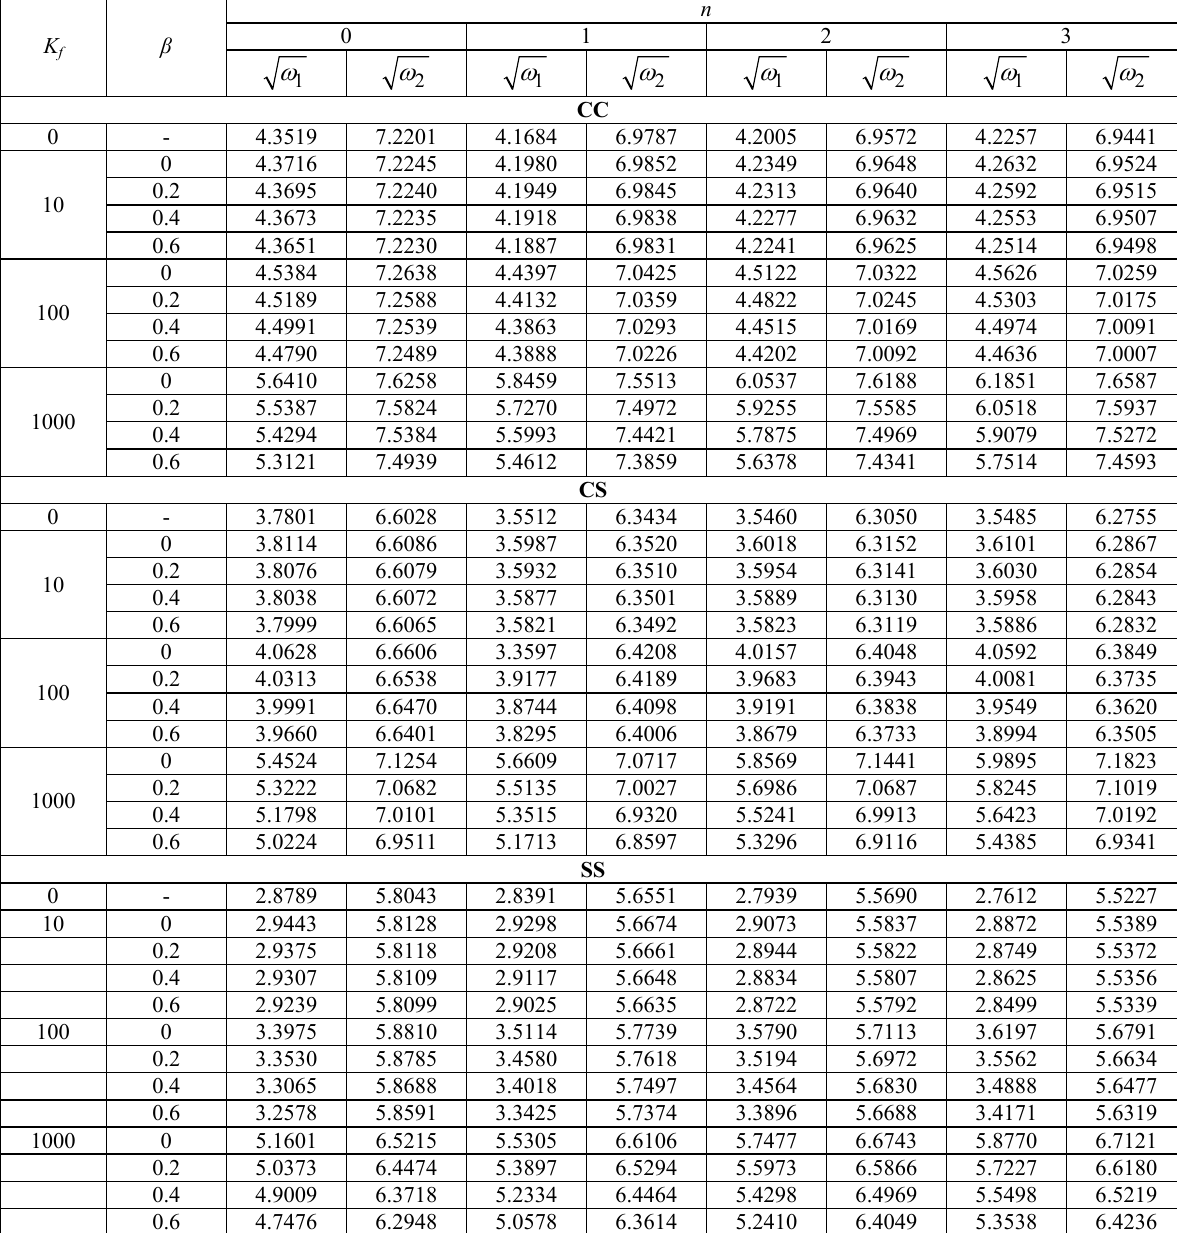
Table 3. Effect of foundation stiffness ( K f ), stiffness variation parameter ( β ), and material gradation index ( n ) on the natural frequency of the system, CC, and CS boundary